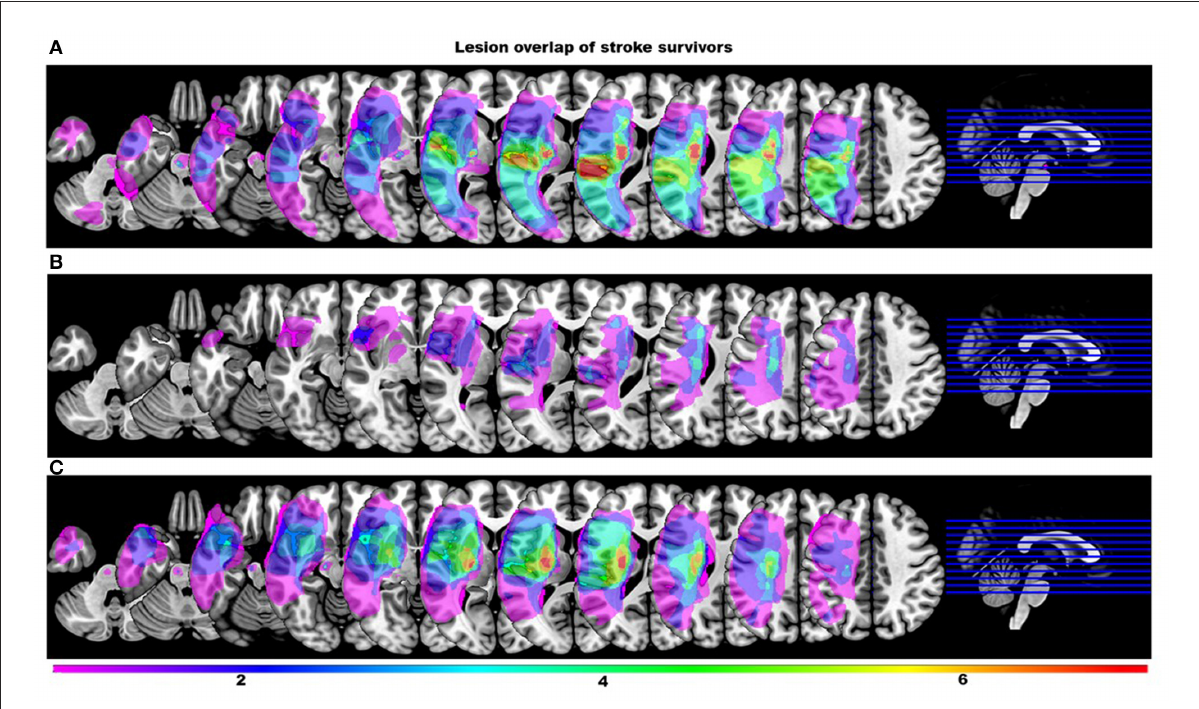
FIGURE1 Lesion overlay maps of stroke survivors stratified by the number of modules. Color scale indicates the number of stroke survivors having a lesion in every voxel (all right sided lesions are flipped to the left hemisphere for clarity). (A) Overlay maps of stroke survivors with more than two modules. (B) Overlay maps of stroke survivors with two modules that were incorrectly classified by the classification tree as individuals with more than two modules. (C) Overlay maps of stroke survivors with two modules correctly classified by the classification tree.